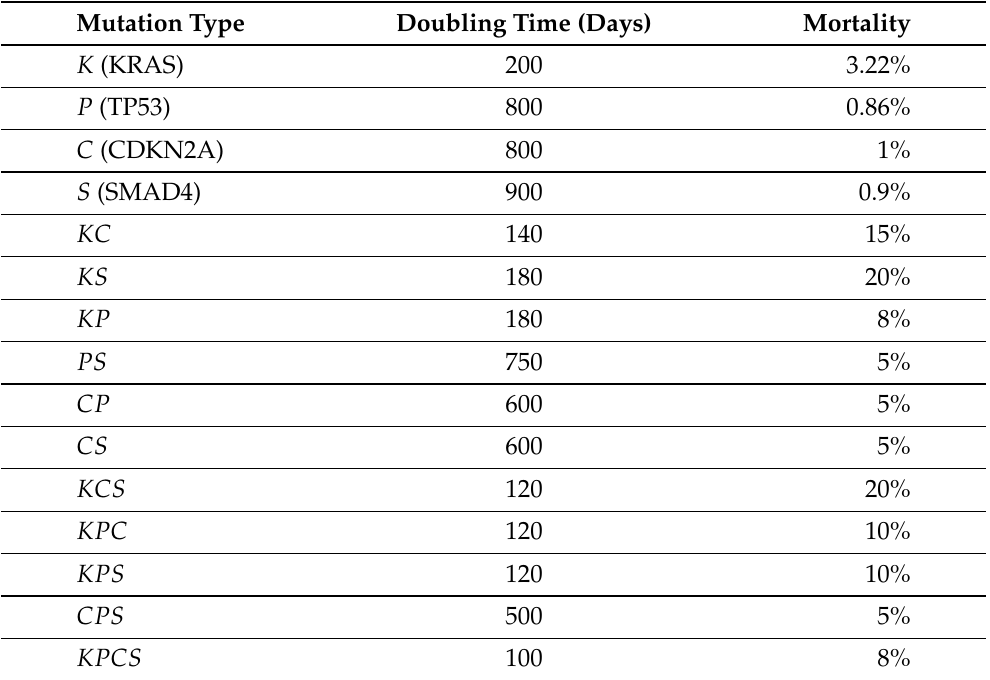
Table 1. Data on doubling times and mortality rates for cell types bearing specific